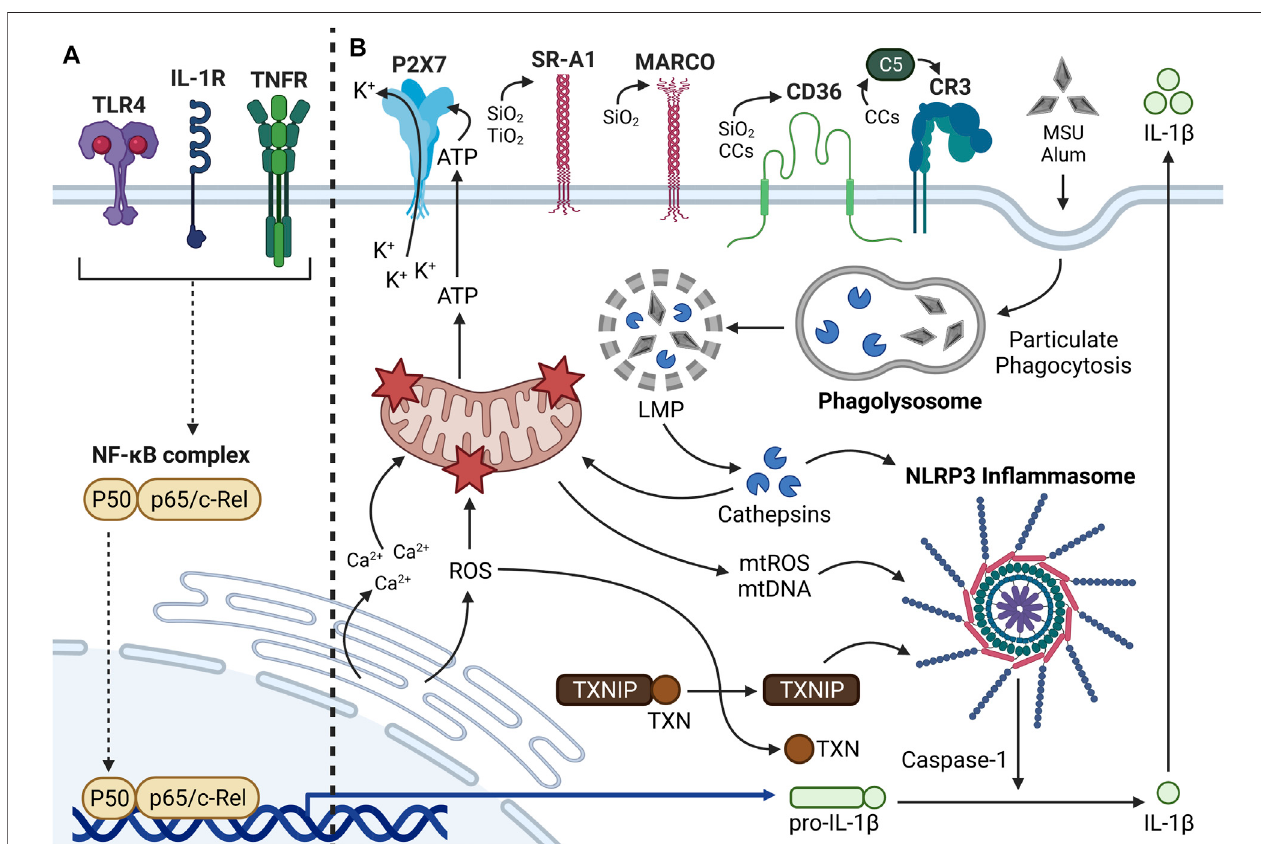
FIGURE 3 | Mechanisms of Signal 2 in fl ammasome activation. (A) Summary of Signal 1 in fl ammasome priming. Translocation of NF- κ B into the nucleus leads to upregulationofproin fl ammatorycytokinessuchaspro-IL-1 β andin fl ammasomesubunits(i.e.,NLRP3,ASC,pro-caspase-1;notshown). (B) TheNLRP3in fl ammasome isacytosolicmultiprotein complexthat promotes proin fl ammatorycytokine production inresponsetoextracellularstimuli and intracellularstress. Many extracellularand intracellular components can be involved in particle-driven in fl ammasome oligomerization and activity. Some particles (e.g., SiO 2 , TiO 2 , CCs) bind transmembrane receptors prior to phagocytosis, whereas other particles (e.g., MSU, alum) interact directly with the plasma membrane. Following phagocytosis, the particle-containing phagosomes fuse with a lysosome to form a phagolysosome. Through unde fi ned mechanisms, the particles aggravate the phagolysosomal membrane and induce lysosomal membrane permeabilization (LMP), which causes release of lysosomal proteases called cathepsins into the cytosol. Some cathepsins such as cathepsin B can directly trigger in fl ammasome oligomerization. Cathepsins can cause mitochondrial dysfunction and release of mtDAMPs (e.g., ATP, mtROS, mtDNA) into the cytosol. ATP released from dying phagocytes can interact with P2X7 receptors and trigger K + ef fl ux, which can contribute to in fl ammasome activation. mtROS and mtDNA can also contribute signi fi cantly to in fl ammasome oligomerization. Mitochondrial dysfunction can alternatively be elicited by CHOP-mediated Ca 2+ release and ROS production from the ER. Cytosolic ROS contributes to dissociation of TXN from TXNIP, the latter of which can promote in fl ammasome activation. Once the in fl ammasome isassembled, pro-caspase-1 proteolyticallyactivates adjacentpro-caspase-1 moieties. Activatedcaspase-1 then proteolyticallyprocesses pro-IL-1 β to IL-1 β , which is ultimately released from the cell to interact with IL-1R on neighboring phagocytes.